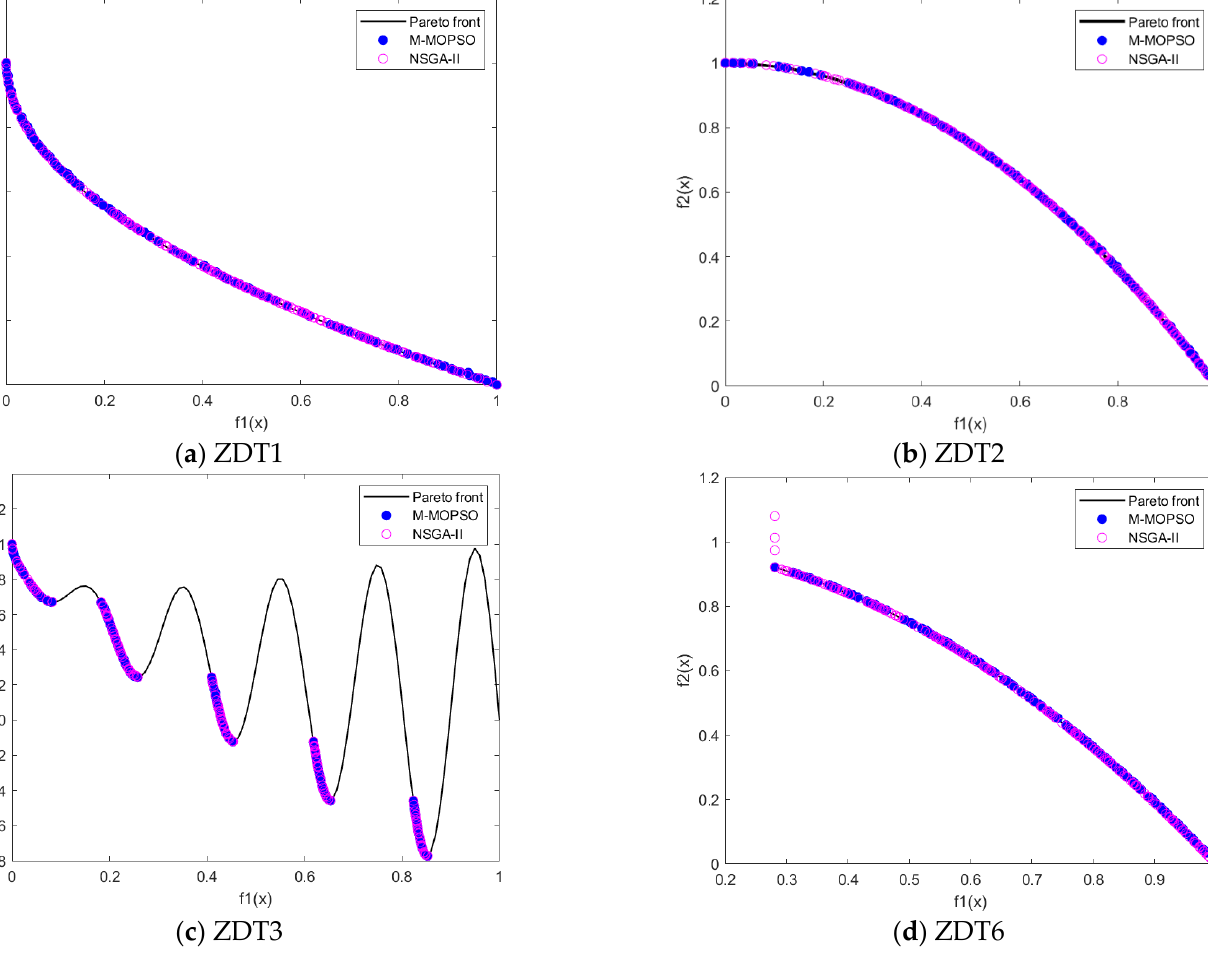
Figure 4. Comparison of Pareto front solution sets for the test functions.